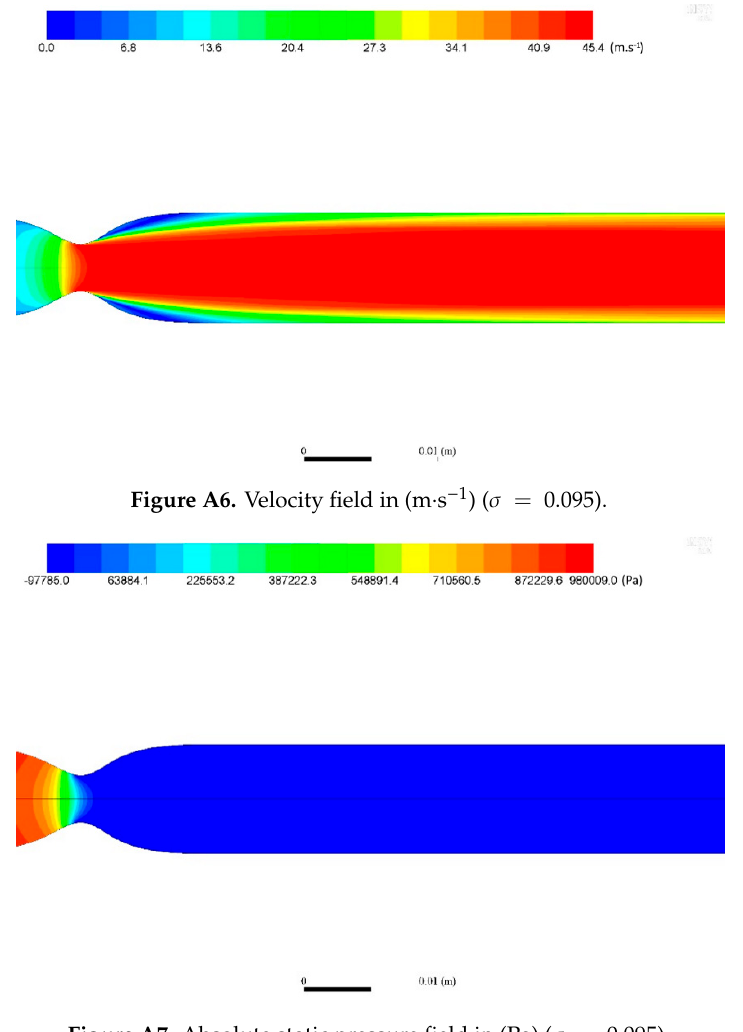
Figure A7. Absolute static pressure field in (Pa) ( 𝜎 = 0.095 ).